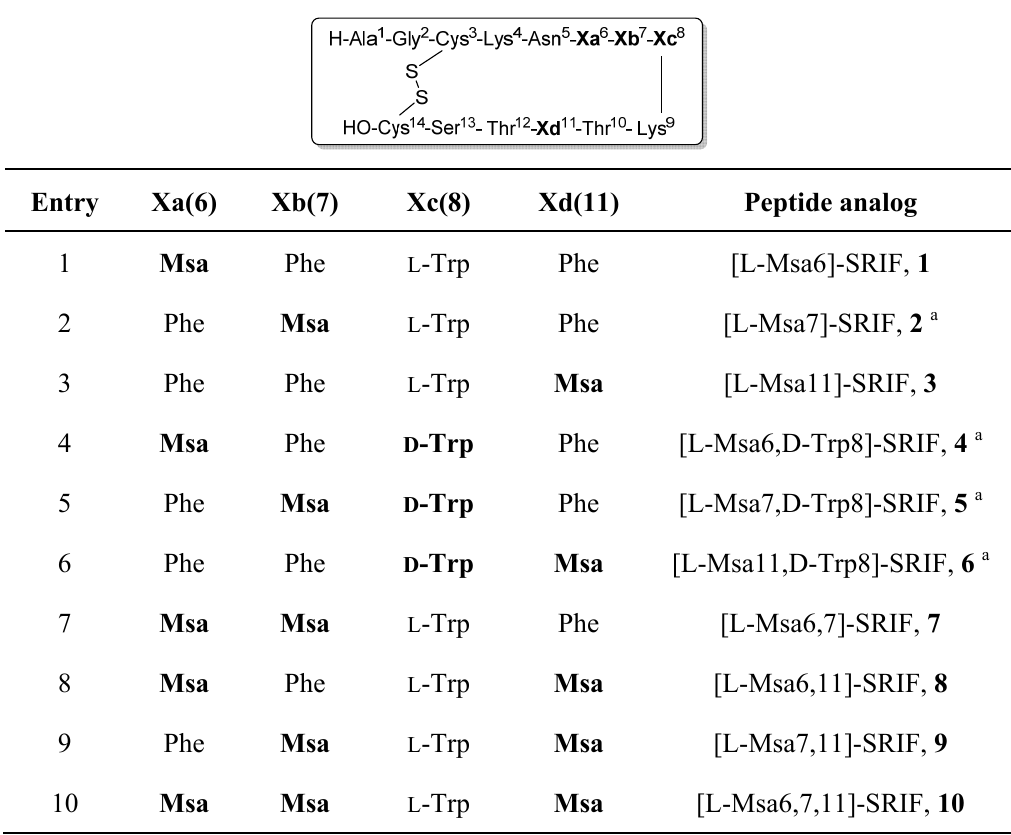
Table 1. Somatostatin analogs obtained by replacement of the Phe in positions 6, 7 and/or 11 by mesitylalanine (Msa). In compounds 4 – 6 the natural Trp in position 8 was replaced by D